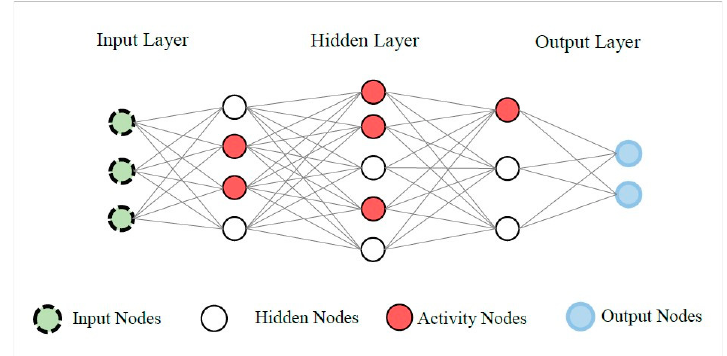
Figure 12. Activating some hidden nodes.